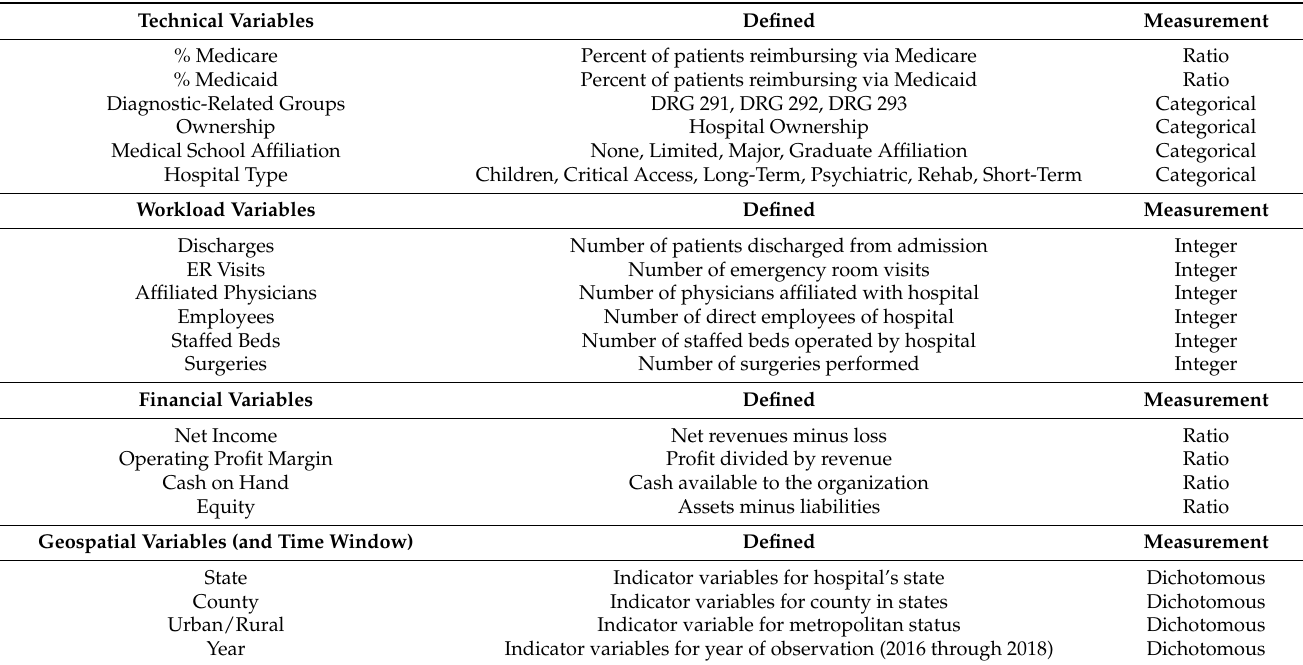
Table 1. Independent